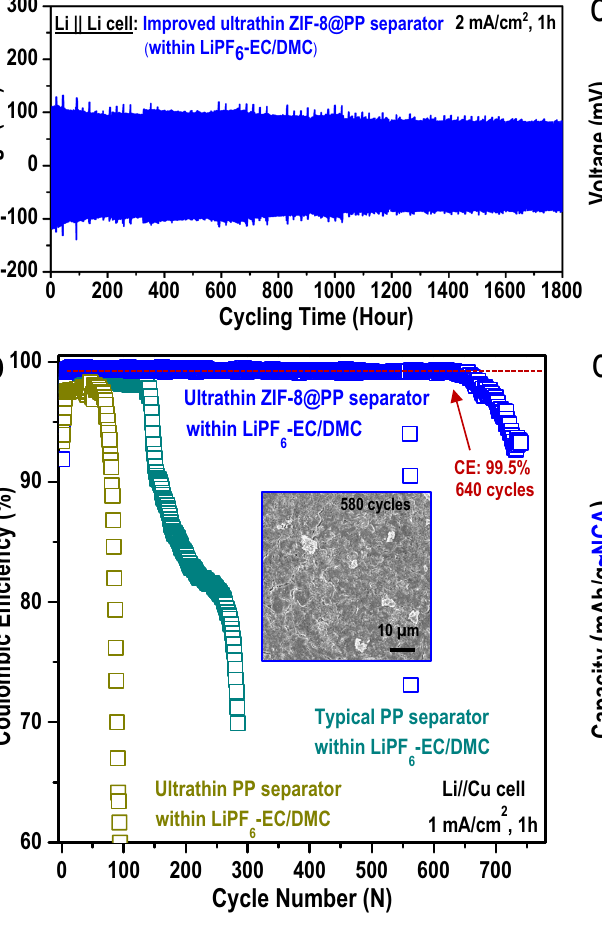
Fig. 5 | Evaluation of Li-metal plating/stripping reversibility and the cycling performanceofanNCA||Lifull-cellassembledwiththeimprovedultrathinZIF- 8@PP separator and two-fold excess lithium predeposited. a Li||Li symmetric cellassembledwithanimprovedultrathinZIF-8@PPseparator(9 µ mthickness)ina typical 1mol/L LiPF 6 -EC-DMC carbonate-based electrolyte: 2mA/cm 2 , 1h. b Coulombic ef fi ciency (CE) of a Li||Cu half-cell assembled with the improved ultrathin ZIF-8@PP separator (9 µ m thickness) in a typical 1mol/L LiPF 6 -EC-DMC carbonate-based electrolyte: 1mA/cm 2 , 1h. The CEs of Li||Cu half-cells